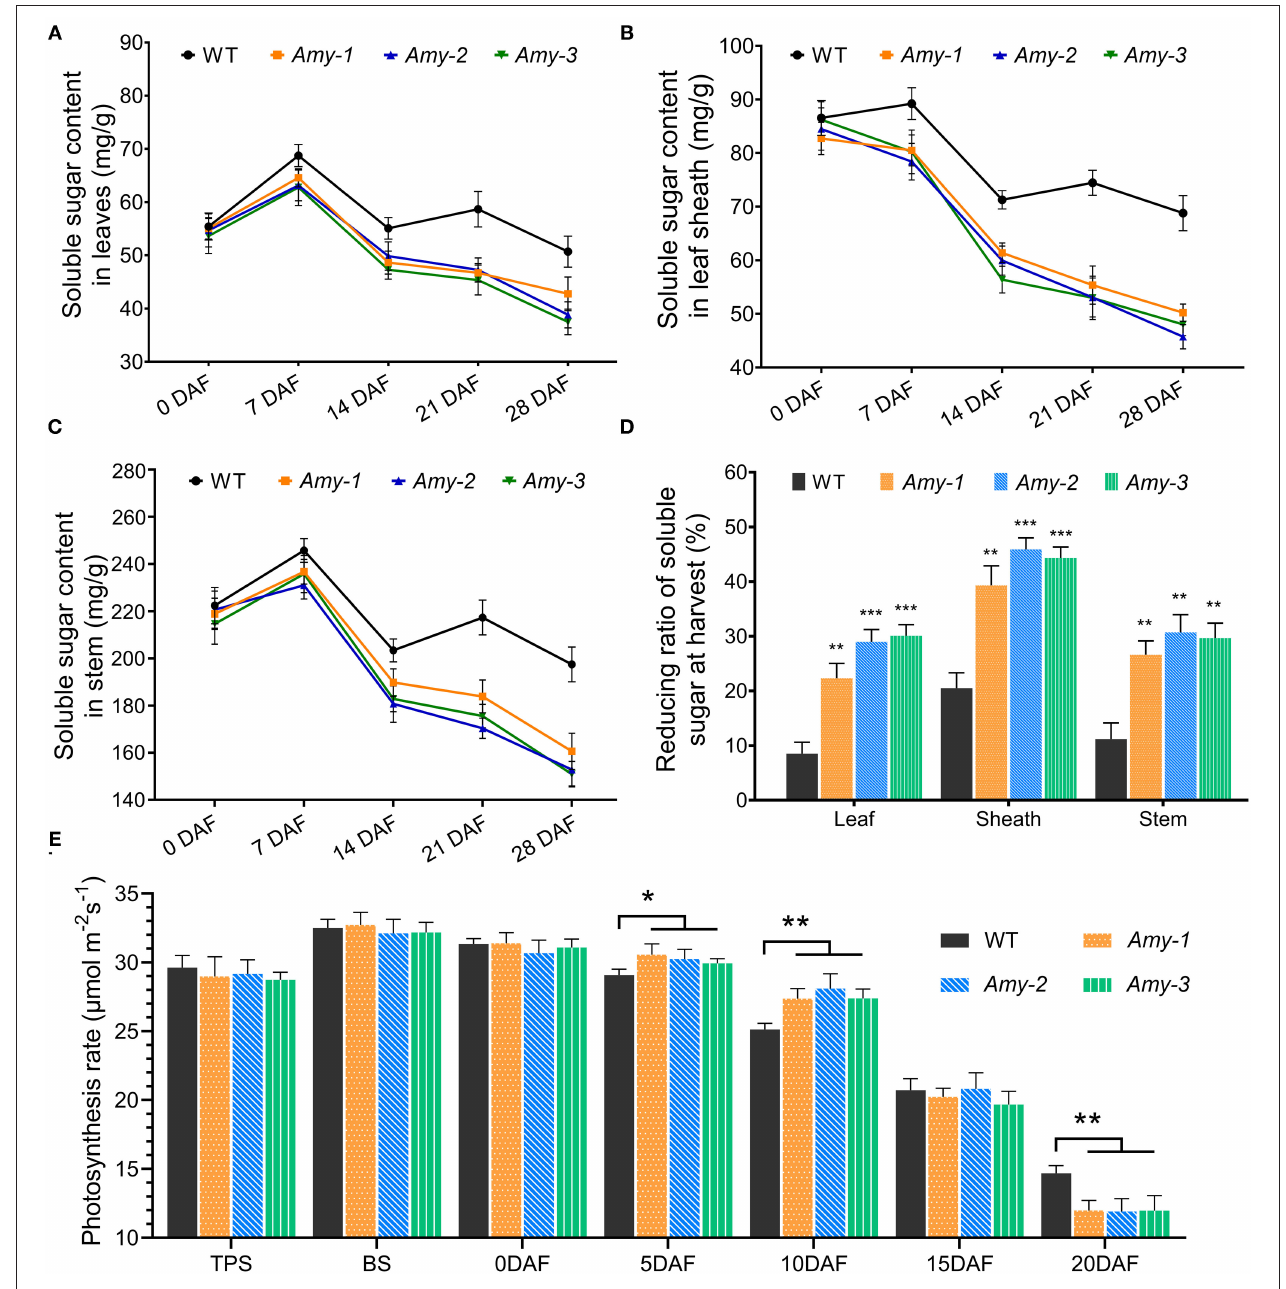
FIGURE 5 | Soluble sugar content in stems, leaf sheaths, and leaves of transgenic rice plants and the Pn of rice plants. (A – C) Soluble sugar content in rice leaf, stem, and leaf sheath at the grain-filling stage. (D) Reducing ratio of soluble sugar content in source tissues at harvest. (E) Rice leaf Pn at different growth stages; namely the TPS-top tilling stage, BS-booting stage, DAF-day after flowering. Asterisks indicate significant differences compared with WT, as determined by Student’s t -test. * P < 0.05; ** P < 0.01; *** P < 0.001. Bars indicate standard deviations of at least three independent plants.